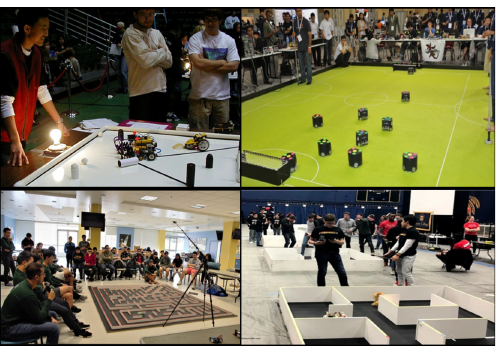
Figure 2. Robot competition: Botball, RoboCup Soccer, MicroMouse, and